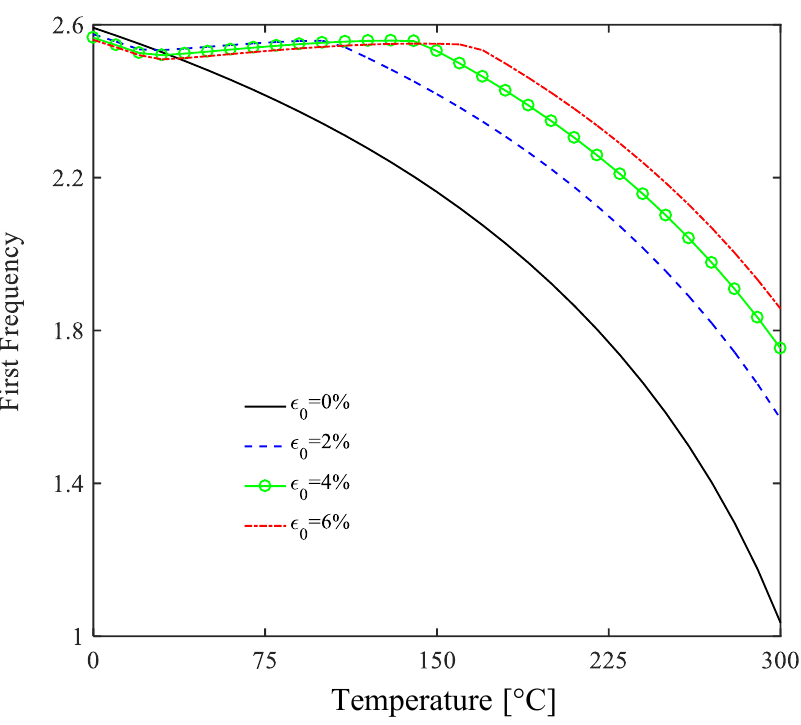
Figure 10. Variation of the first dimensionless frequency vs. temperature for different values of SMA initial pre-strain and a uniform temperature ( V SMA = 0.2, h c / h = 0.5 and n = 1).